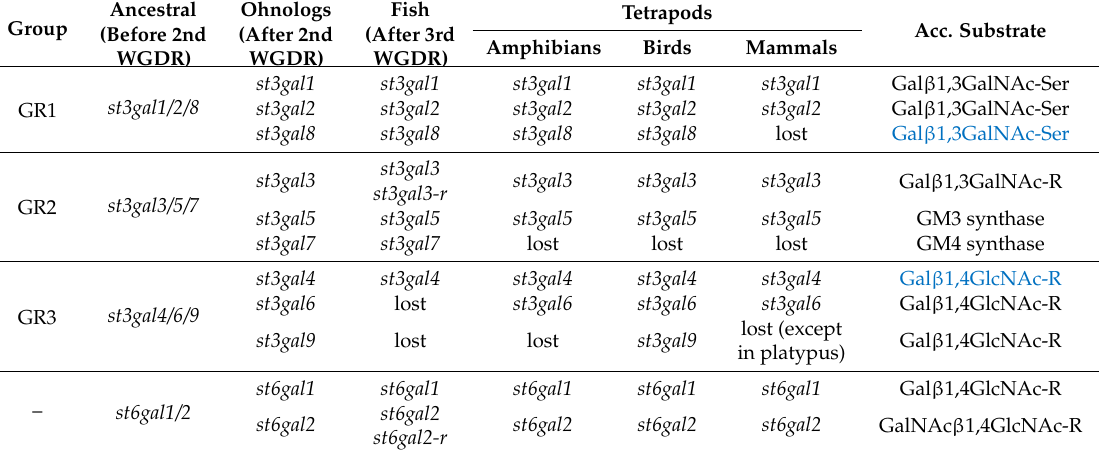
Table 1. Vertebrate β -galactoside α 2,3/6-sialyltransferases ohnologs: Vertebrate β -galactoside α 2,3/6-sialyltransferase sequences belonging to the ST3Gal and ST6Gal families are grouped in 4 clades with distinct evolutionary origins (GR1, GR2 and GR3 for the ST3Gal and a unique group for the ST6Gal) encompassing 9 st3gal and 2 st6gal ohnologs. Acceptor substrate preferences of the mammalian enzymes and predicted acceptor substrate preference (in blue) of the novel vertebrate enzymes lost in mammals are